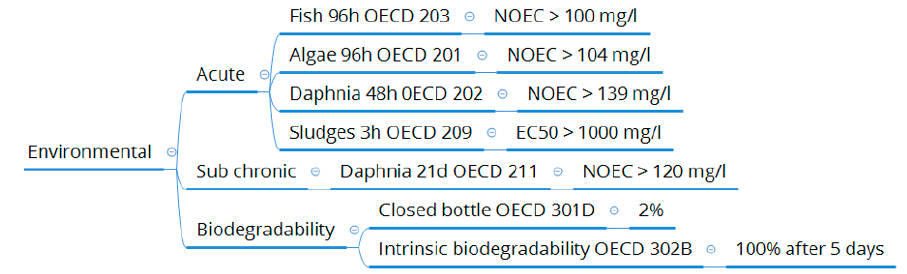
Figure 9. Eco-toxicological tests summary for 2-MeOx.